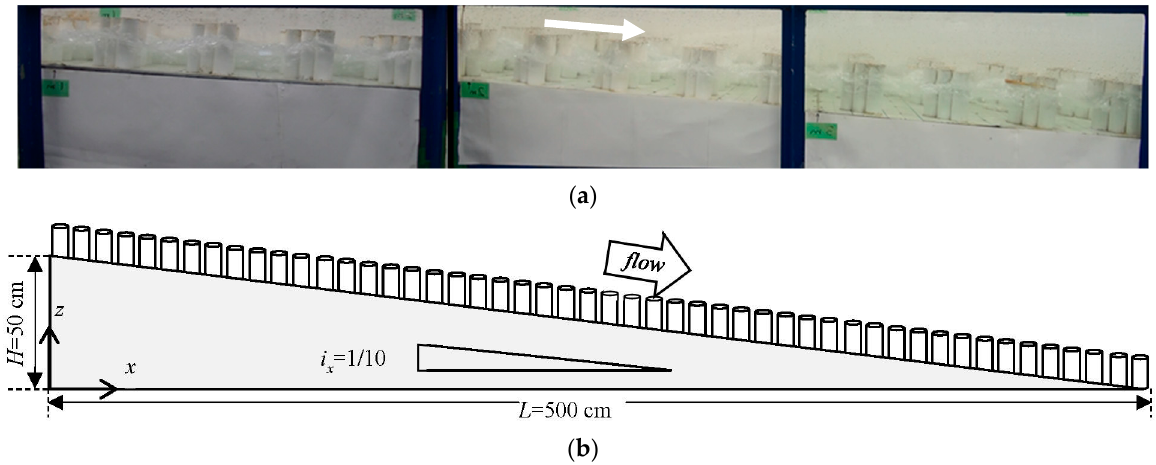
Figure 3. The fishway used in the experiment: ( a ) Longitudinal photo of the fishway; ( b ) The cross section plan of the fishway.